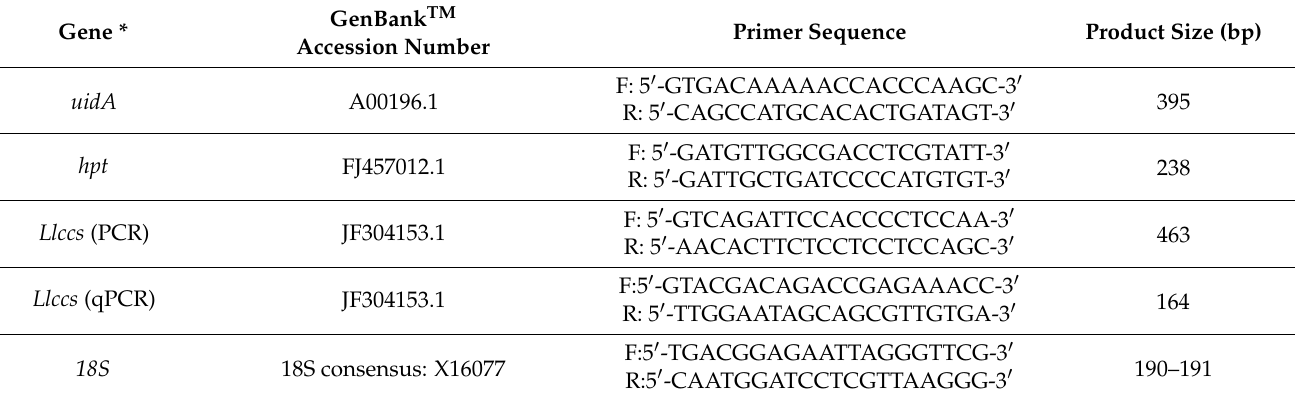
Table 2. The list of primer sequences that were used in current